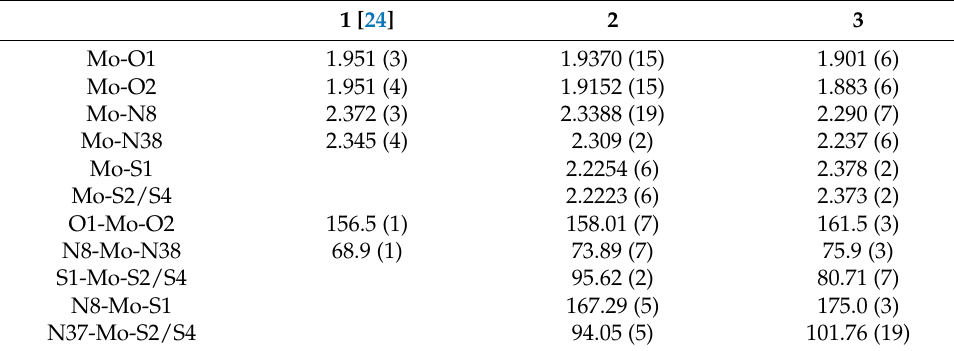
Table 1. Selected bond lengths (Å) and angles ( ◦ ) for studied